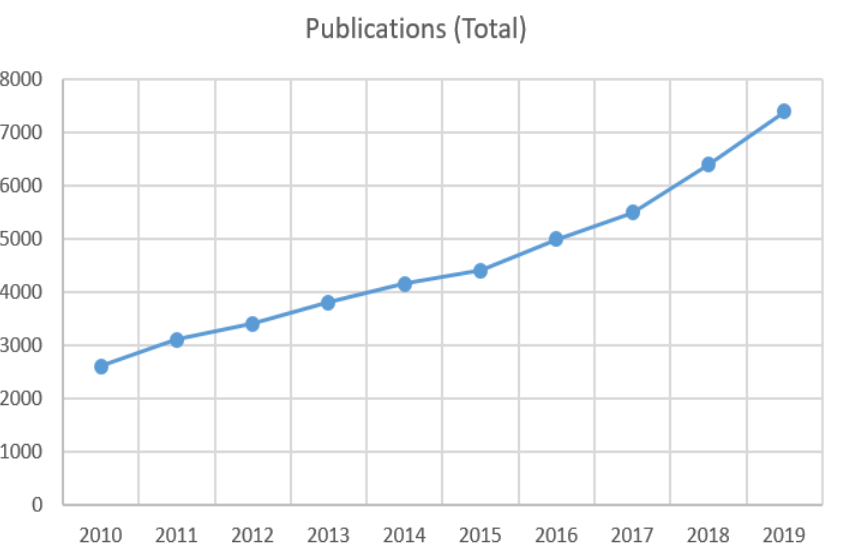
Figure 1. The increasing number of publications in road scene understanding from 2010 to 2019. Data from Google Scholar advanced search: allintitle: “on-road behavior understanding” AND “on-road behavior analysis